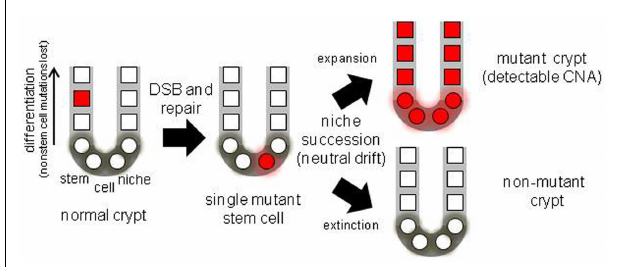
FIGURE 1 | Diagram of a colon crypt stem cell niche, illustrating niche stem cell turnover .With multiple niche stem cells, a mutation will become detectable if its stem cell eventually dominates its